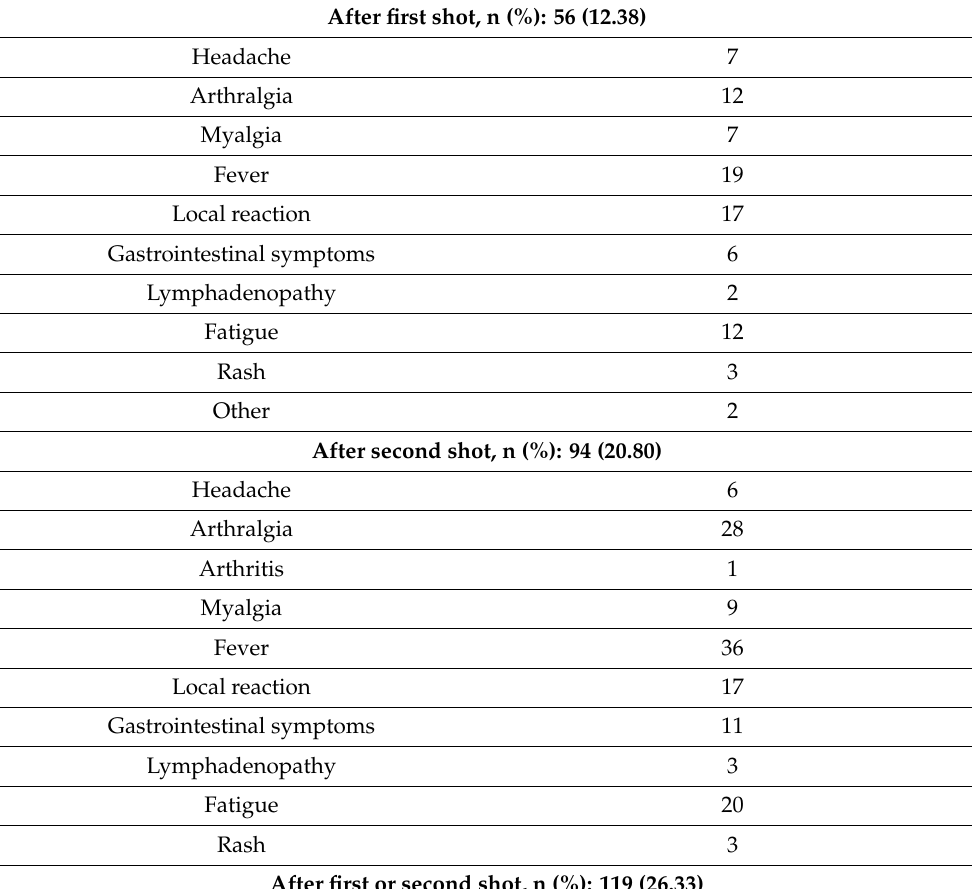
Rash 3 After first or second shot, n (%): 119